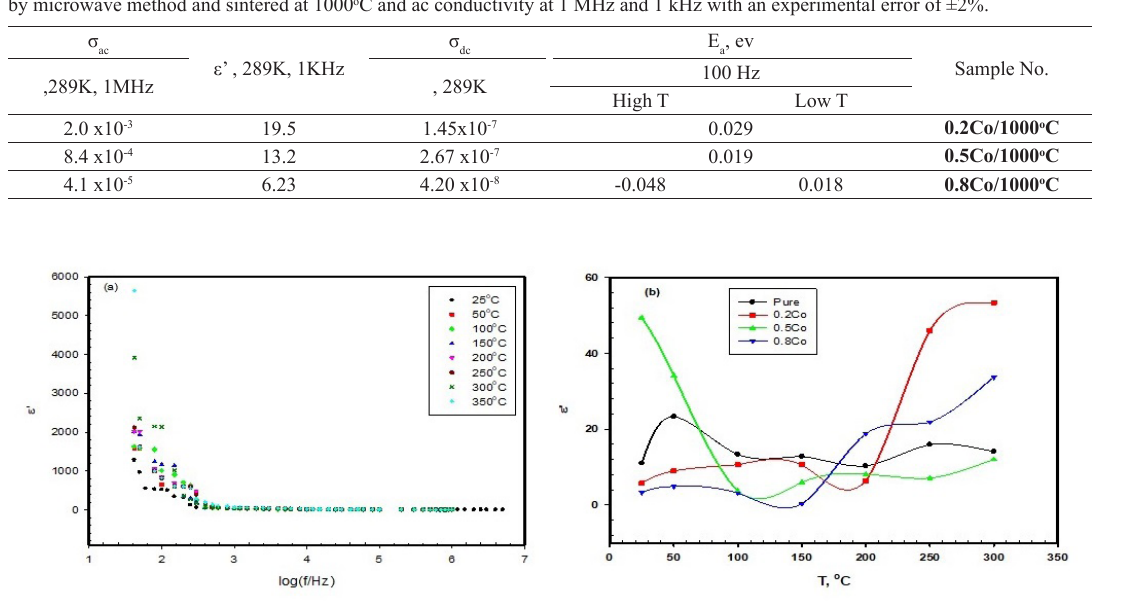
Co Zn Fe O as anode and cathode electrocatalysis. The first x 1-x 2 4 replacement of Zn by 0.2Co (Co